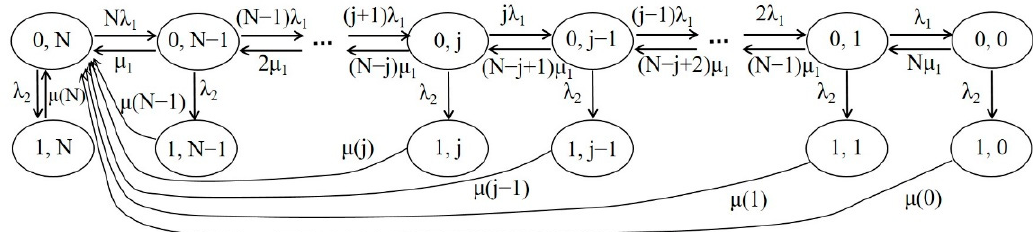
Figure 5. State transition diagram of the IoT system.